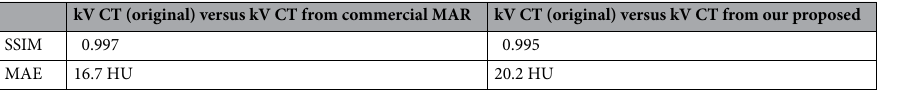
Table 2. Numerical information about image similarity of resulting images throughout Network 2 for slices not containing severe metal artifacts, and having max. HU > 4000.